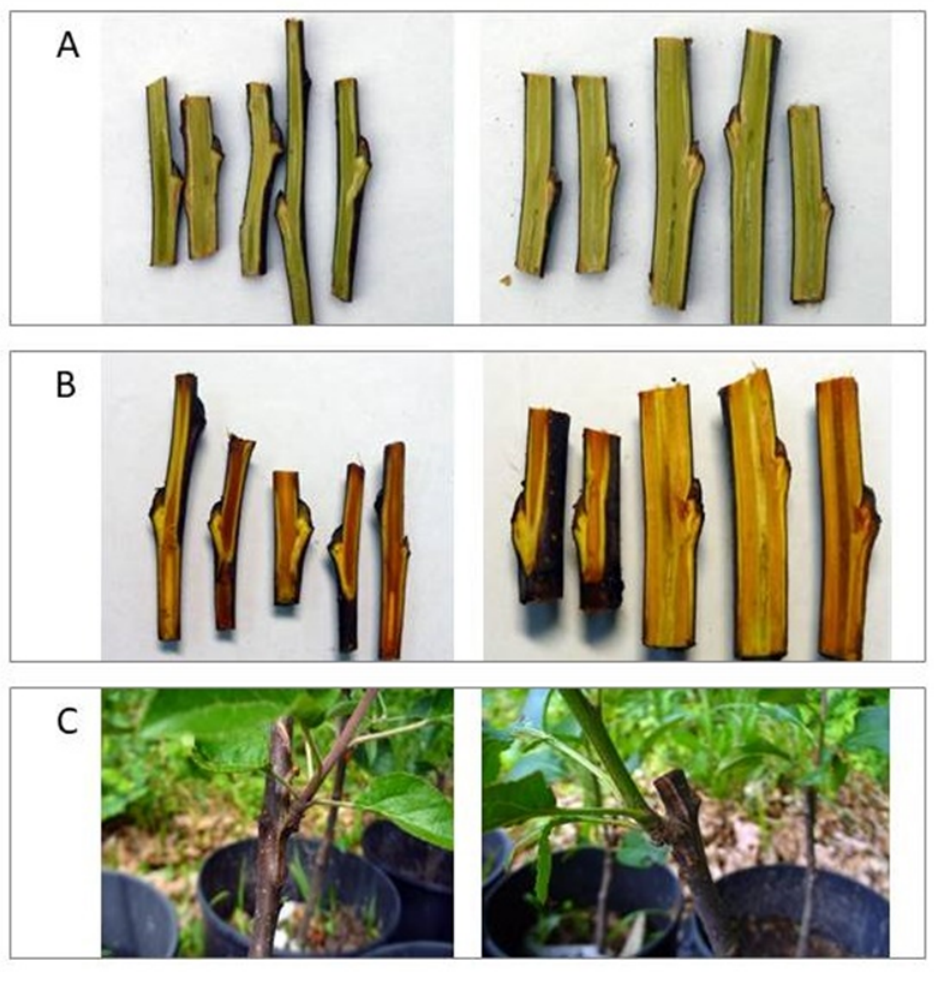
Figure 2 Dormant buds of historical apple tree varieties: ‘Spasówka’ variety (le) and ‘Ingrid Marie’ variety (right). ( A ) Non-LN-stored control with bright green stems and buds. ( B ) Storage in LN visibly changes the stem and buds color to dark yellow, which is not associated with the regeneration capacity of buds. ( C ) Regenerated thawed buds graed on rootstocks: ‘Lady Sudeley’ variety (le) and ‘Jaster’ variety